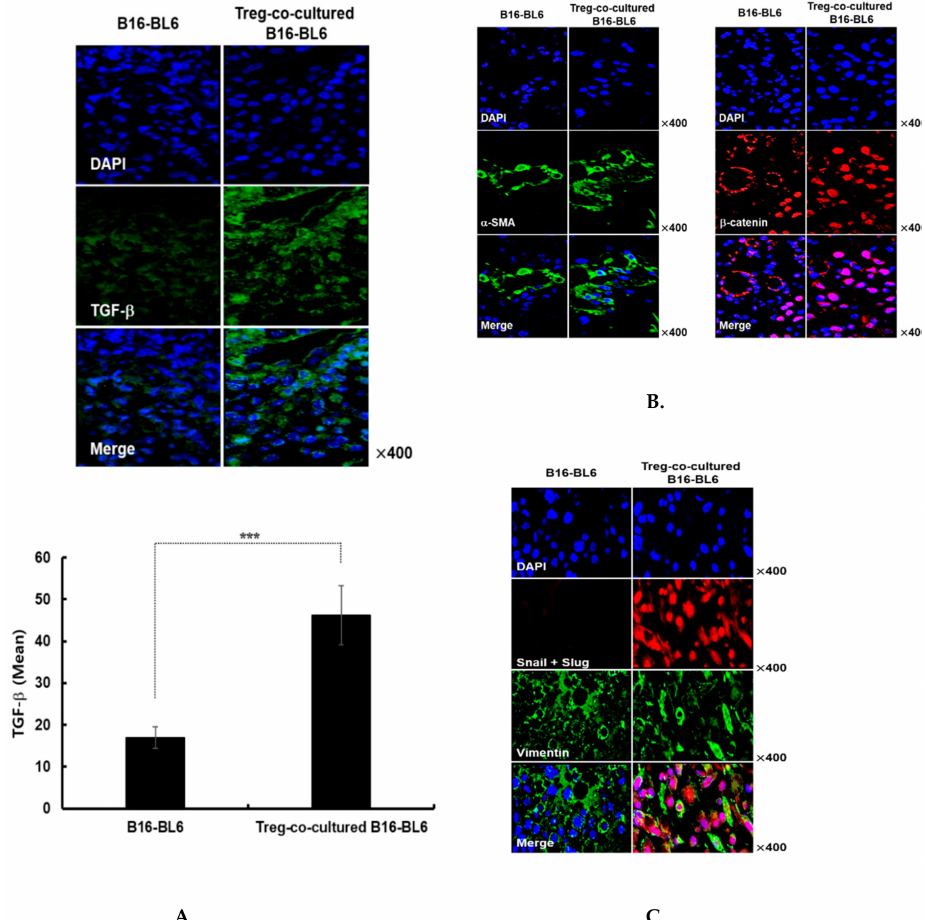
Figure 4. Immunohistochemical assessment of tumors resulting from subcutaneous injection of Treg co-cultured B16-BL6 cells. Tumor tissues were stained with anti- ( A ) TGF- β , ( B ) α -SMA and β -catenin, or ( C ) Snail, Slug, and vimentin antibodies. The TGF- β expression level in tissues was semi-quantitatively analysed by ImageJ software using 5 independent fields within microscope images for each experimental group. Data are presented as mean ± SD. *** p < 0.001. Original magnification: ×